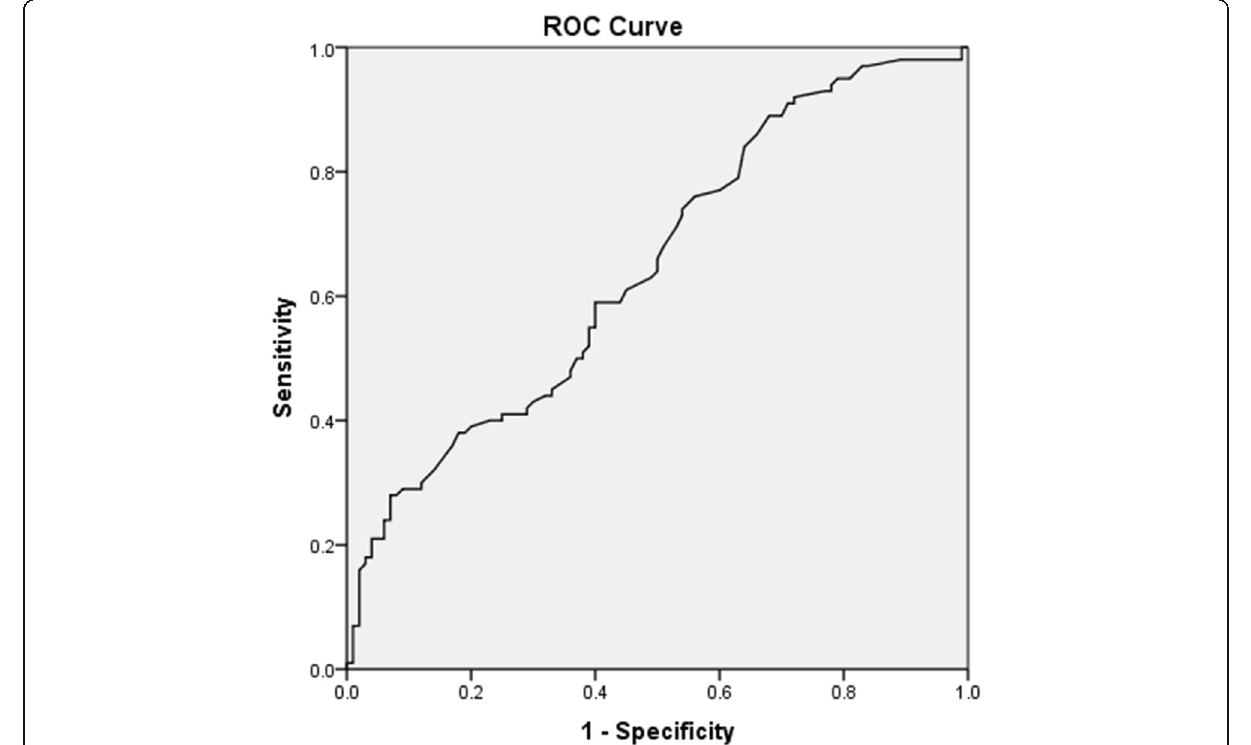
Fig. 3 Roc curve analysis of methylation profile of gene-specific MTHFR. AUC, area under the curve; 95% CI, 95% confidence